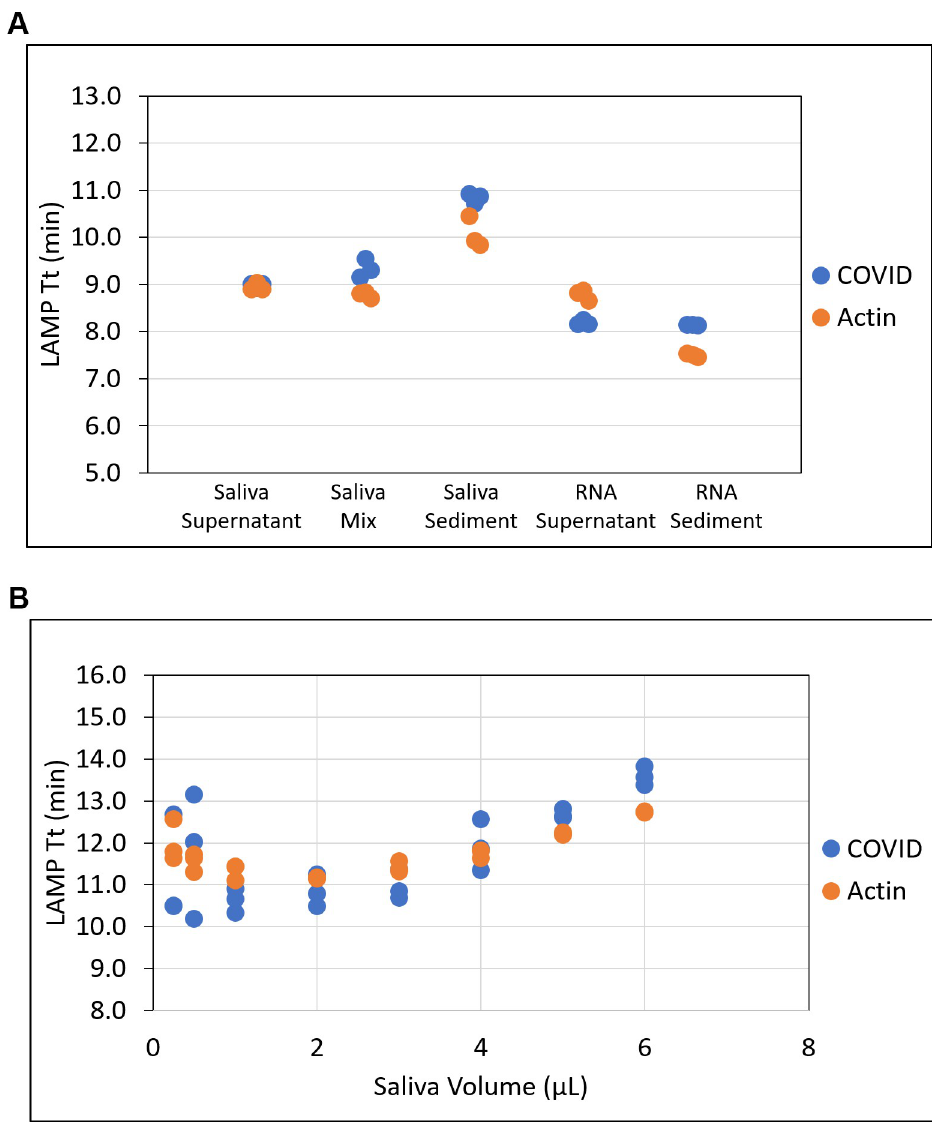
Fig 2. Impact of saliva input on RT-LAMP performance. (A) Naturally-settled, supernatant and sediment from positive saliva and corresponding purified RNAs were evaluated in COVID and actin LAMP reactions. (B) Different volumes of positive saliva ranging from 0.25 μ L to 6 μ L were used in COVID and actin LAMP reactions. LAMP Tt values were plotted. All samples were tested in triplicate. negative individuals and used to determine the limit of detection (LoD). Twenty replicate samples were prepared from each pool and spiked with 40 copies of virus / μ L and then tested in triplicate. All 60 reactions from each of the 2 pools (Fig 4) scored positive (100% sensitivity) within 10 (pool 1) or 11 (pool 2) minutes. When spiked with fewer copies of virus, the viral RNA was also detected but at a reduced frequency. At 20 copies/ μ L or 10 copies/ μ L, sensitivities of 82% (49/60) and 63% (38/60) were obtained, respectively. The LoD, defined as the lowest concentration that can be detected with a 95% detection rate [37], was calculated to be 39 copies/ μ L using an R script that determines LoD using curve- fitting methods [38].